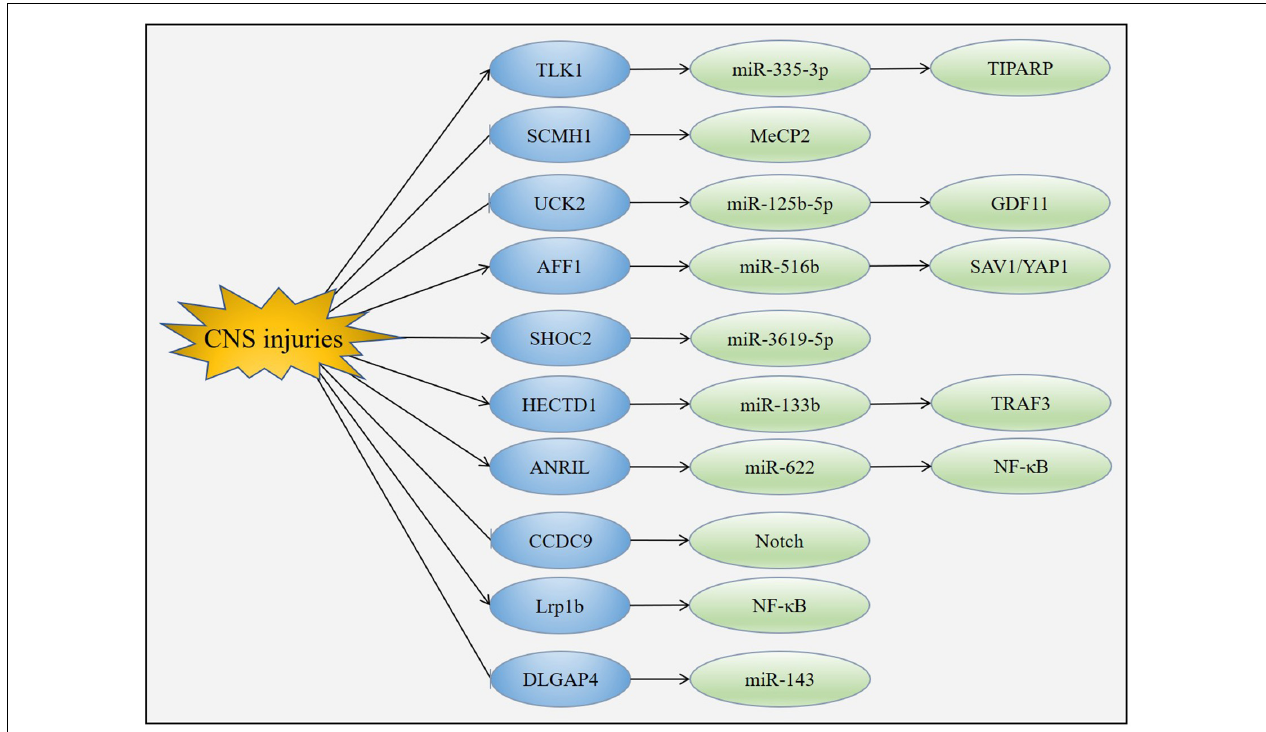
FIGURE 6 | Mechanism of circRNAs in acute CNS injuries. CNS injuries up-regulated the expression of TLK1, AFF1, SHOC2, HECTD1, ANRIL and Lrp1b while down-regulated the expression of SCMH1, UCK2, CCDC9 and DLGAP4. Changes of these circRNAs led to the modulation of downstream molecules such as miRNAs, MeCP2, Notch1 and NF- κ